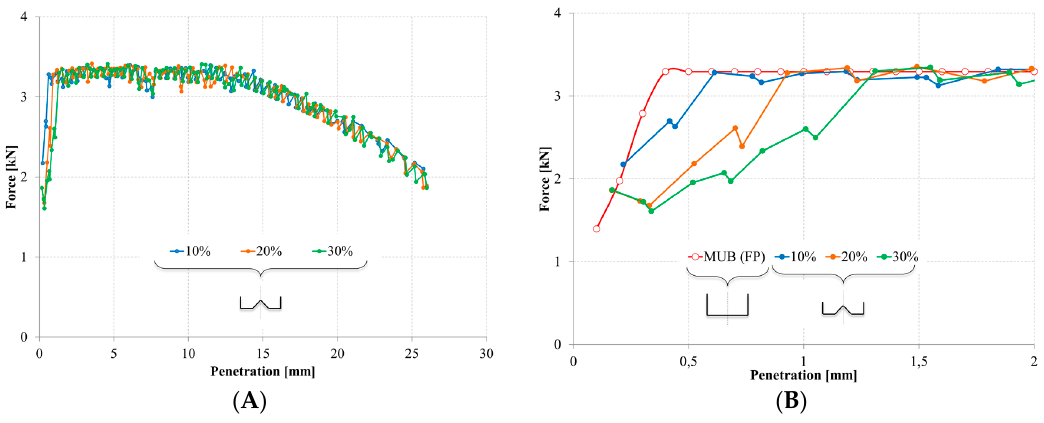
Figure 14. Geometry 4 results ( A ) and first deformation stage details and comparison with MUB ( B ).